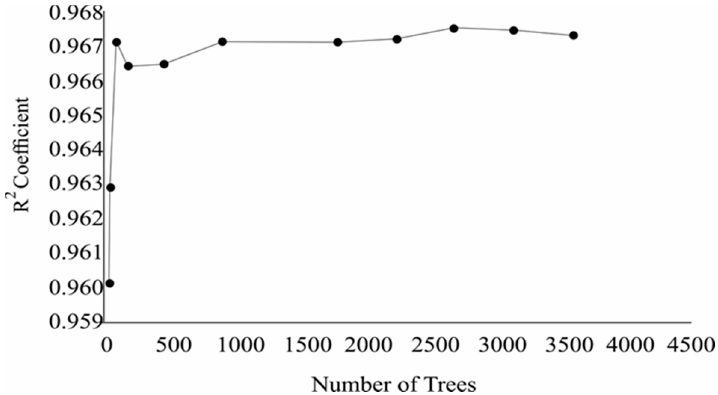
Figure 3. Number of trees according to the R 2 coefficient obtained from RF. The graph corresponds to the area under the curve.